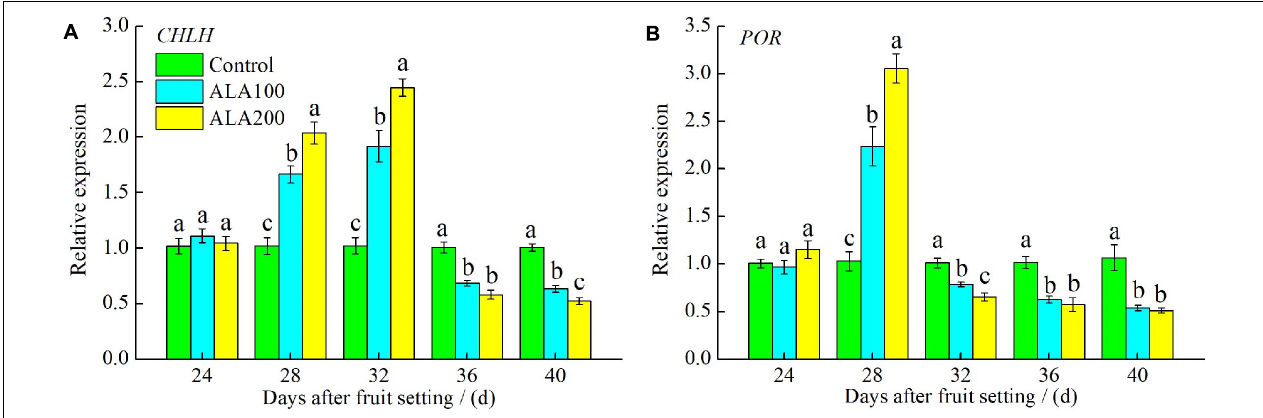
FIGURE 7 | Relative expression of genes involved in ALA metabolic pathway. (A) Relative expression of CHLH , encoding Mg-chelatase; (B) relative expression of POR , encoding protochlorophyllide oxidoreductase. Vertical bars represent mean ± SE from three independent replicates and the different letters denote significant differences ( p < 0.05). The control group was used as reference at each sampling time